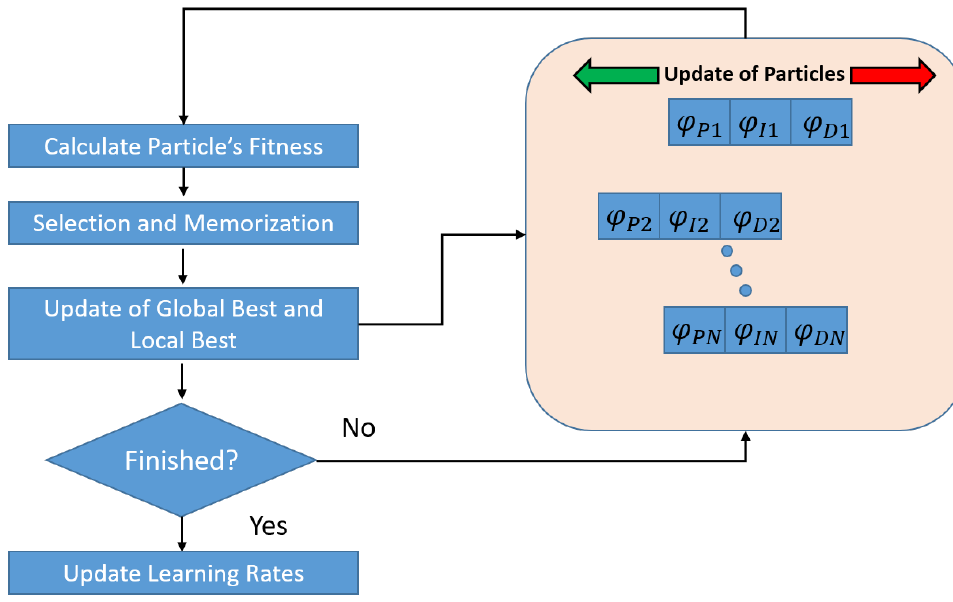
Figure 10. Flow chart of the particle swarm algorithm for adjusting the learning